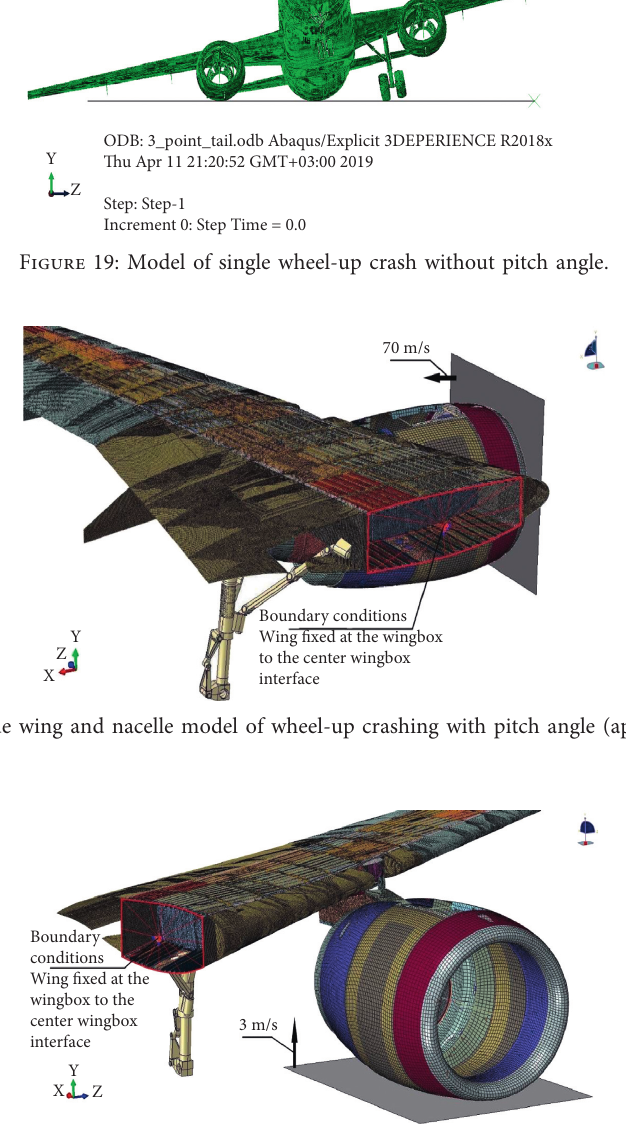
Figure 21: One side wing and nacelle model of wheel-up crashing with pitch angle (vertical